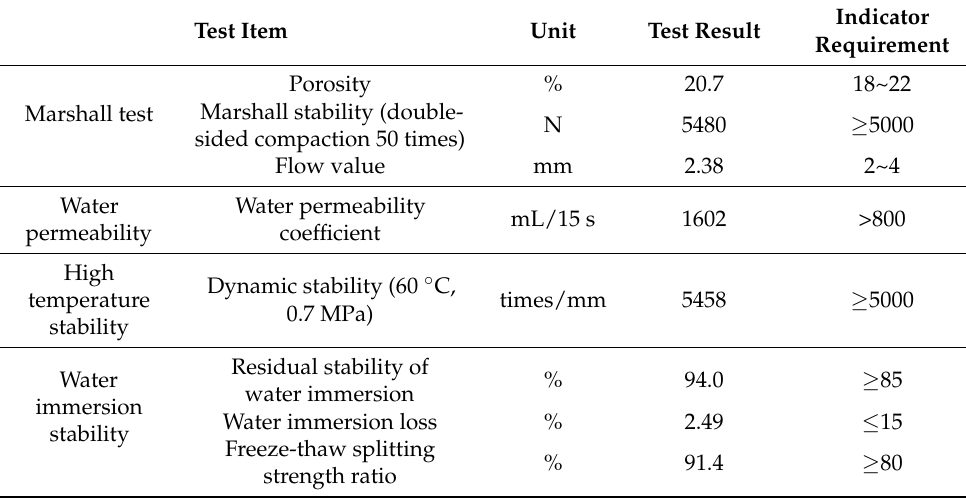
Table 11. Performance verification of porous asphalt mixture.